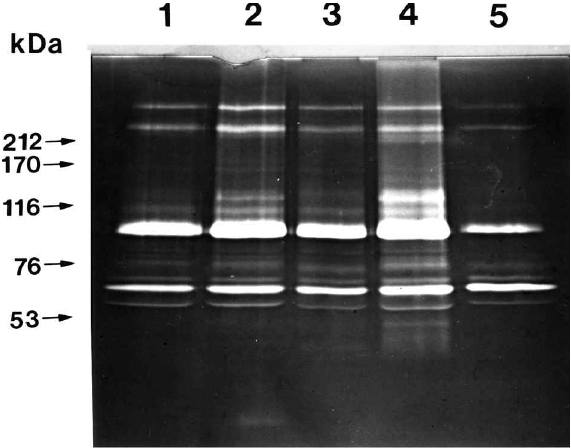
FIG. 1. Zymograms of muscle homogenates from mice injected i.m. with 60 m g of MT-III or BaP1. Gelatinase activity was assessed by sodium dodecyl sulfate-polyacrylamide gel electrophoresis (5–20% acrylamide gradient) containing 1% type A gelatin. Muscle homogenates after injection of: (1) BaP1, 1h; (2) BaP1, 6h; (3) MT-III, 1h; (4) MT-III, 6h; (5) saline. Molecular weight markers are depicted to the left.